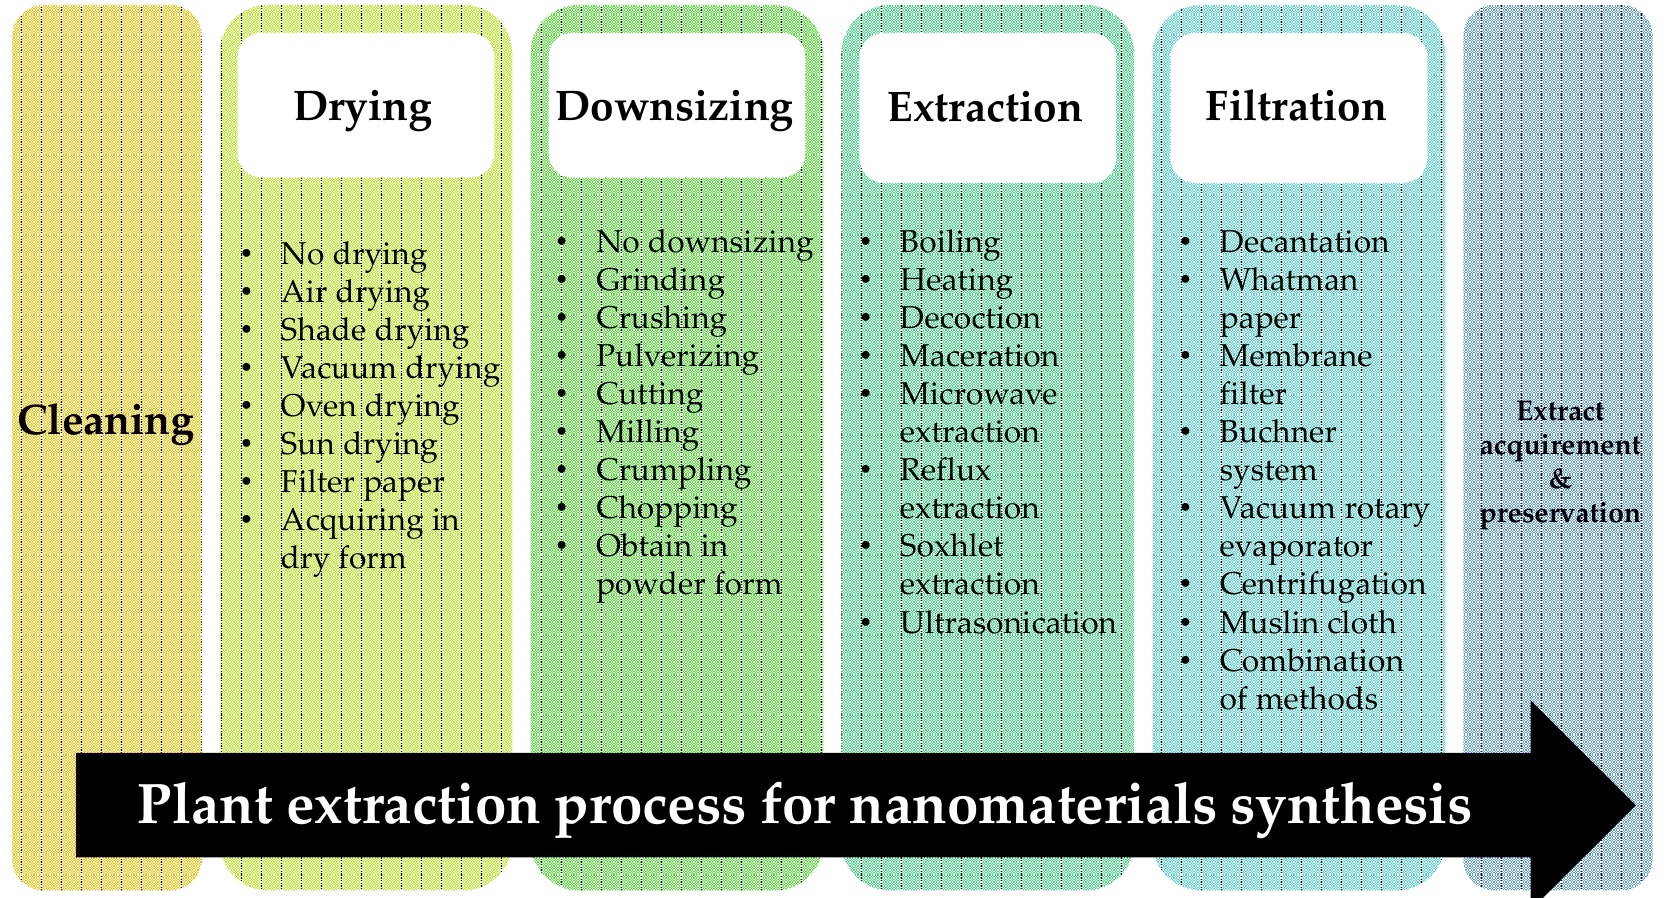
Figure 1. General steps in plant extraction.